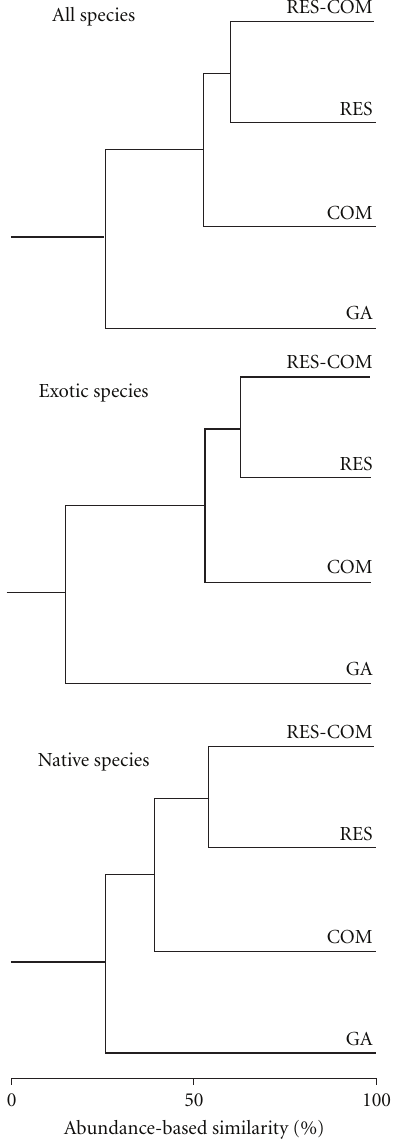
Figure 4: Abundance-based Bray-Curtis multivariate cluster analy- sis depicting tree composition similarity among the studied urban land uses. GA: green areas, RES: residential areas, RES-COM: residential-commercial areas, COM: commercial